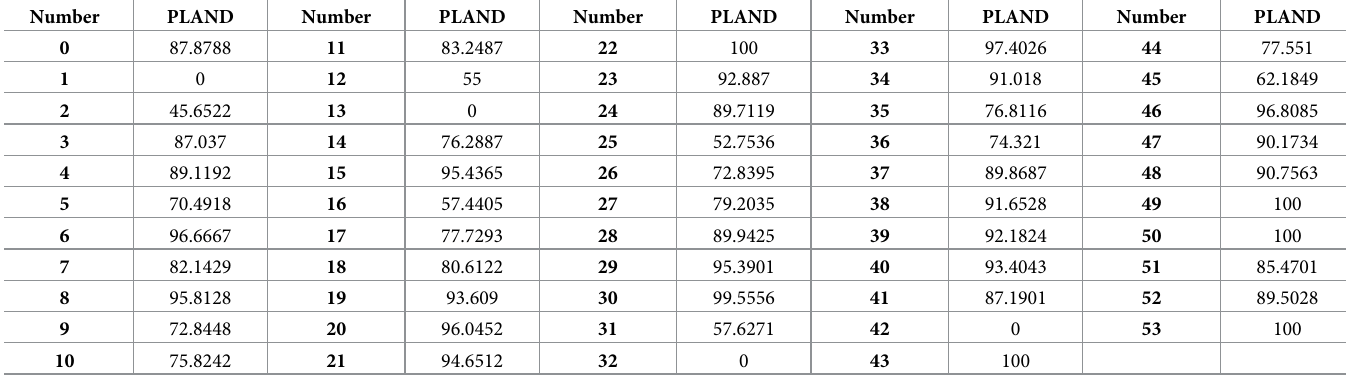
Table 4. PLAND values of individual study